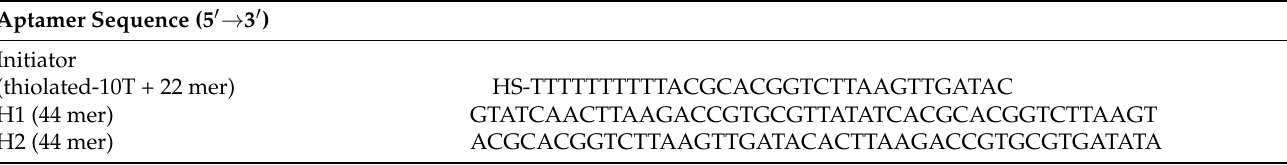
Table 1. Sequence of the DNA aptamers used in this